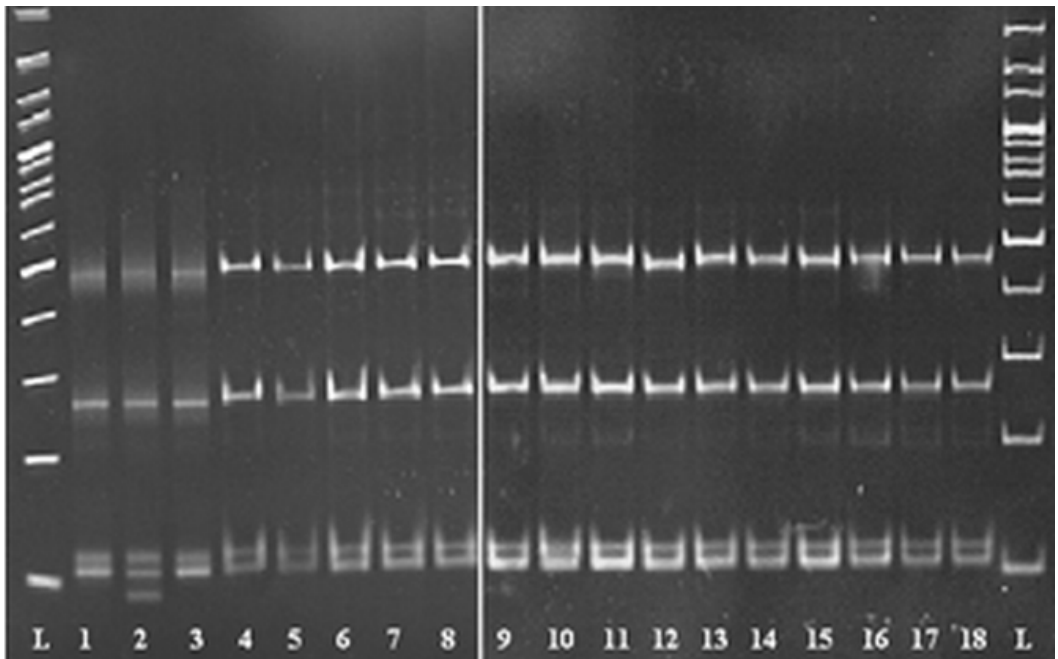
Figure 3. Polyacrylamide gel showing the RFLP patterns of phytoplasma ribosomal protein genes rpl22 and rps3 amplified with rpAP15f/rpAP15r primers digested with Alu I restriction enzyme. Lanes: L – molecular marker 100 bp. 1. J8148, 2. J4020, 3. Przel, 4. SzamP, 5. GoC, 6. GoP, 7. Tward, 8. Oz, 9. RBoC, 10. Bor, 11. JoC , 12. Mut, 13. GlP, 14. Kotlar, 15. Kijak, 16. GDel, 17. Głowno, 18. AP-15 reference